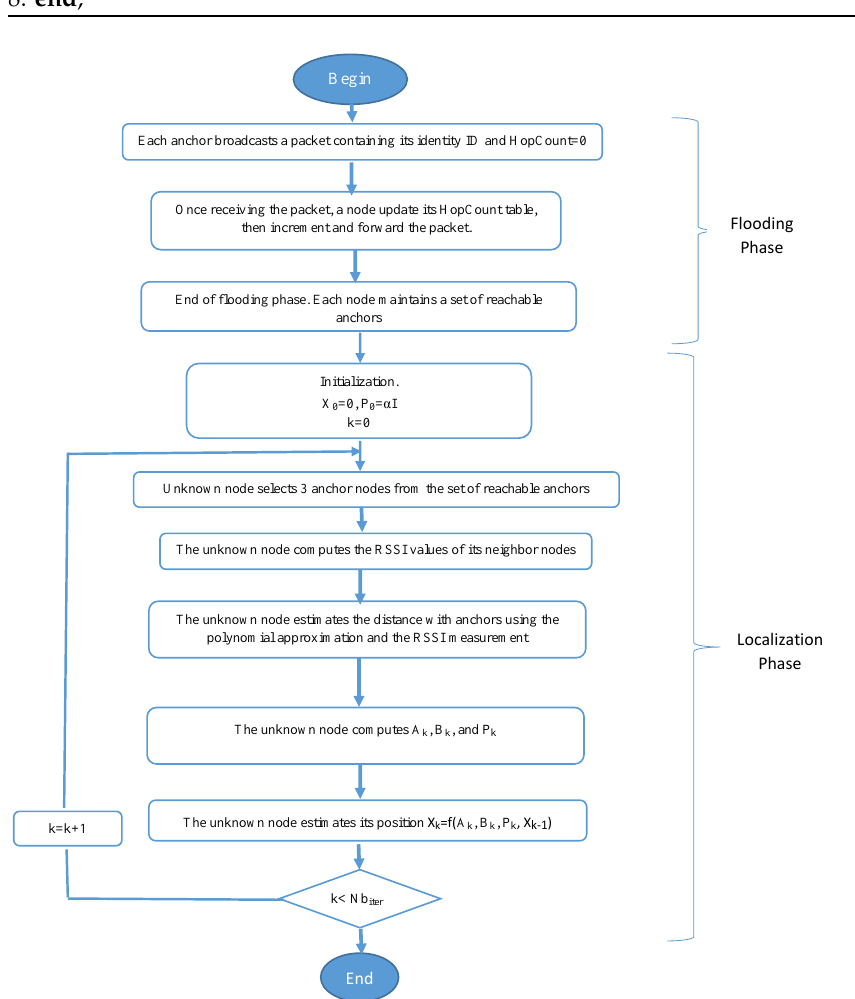
Figure 4. Flowchart of the proposed localization